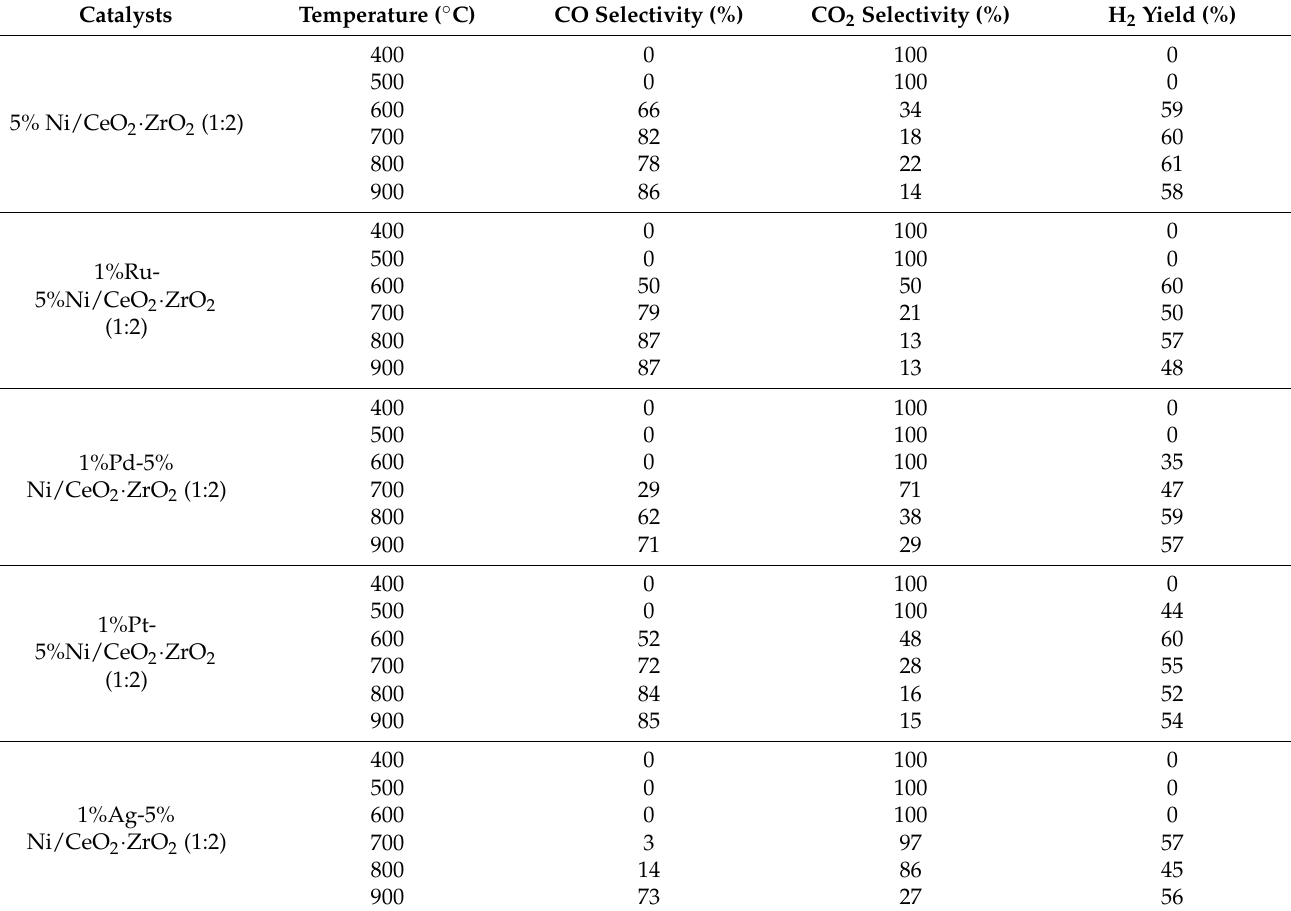
Table 2. Activity of mono- and bimetallic catalysts supported on CeO 2 · ZrO 2 (1:2) system tested in OSR-LNG process.